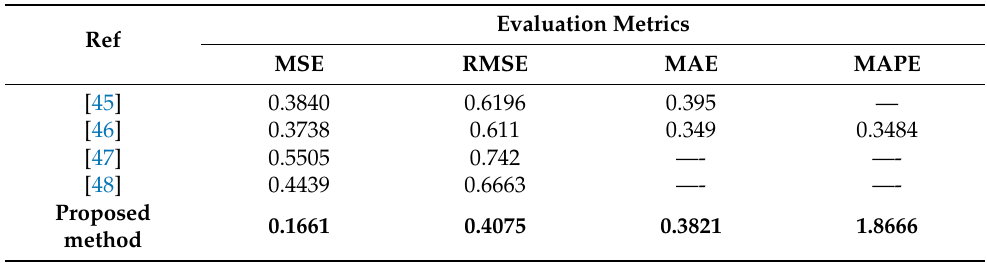
Figure 8. Graphical representation of the prediction of energy based on actual data used. The prediction was obtained using proposed method M-LSTM on different resolutions such as minutes and hours. Table 12. Comparative analysis of the proposed method with state-of-the-art methods where the bold wording represents the proposed